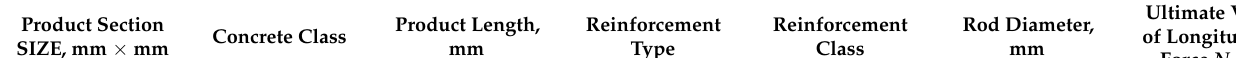
Table 11. Results of calculating the limiting value of the longitudinal force (bearing